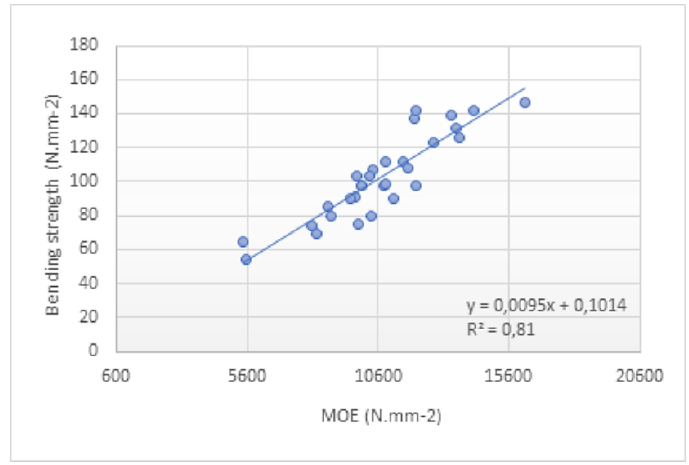
Figure 9. Correlations between bending strength and MOE for all sites.